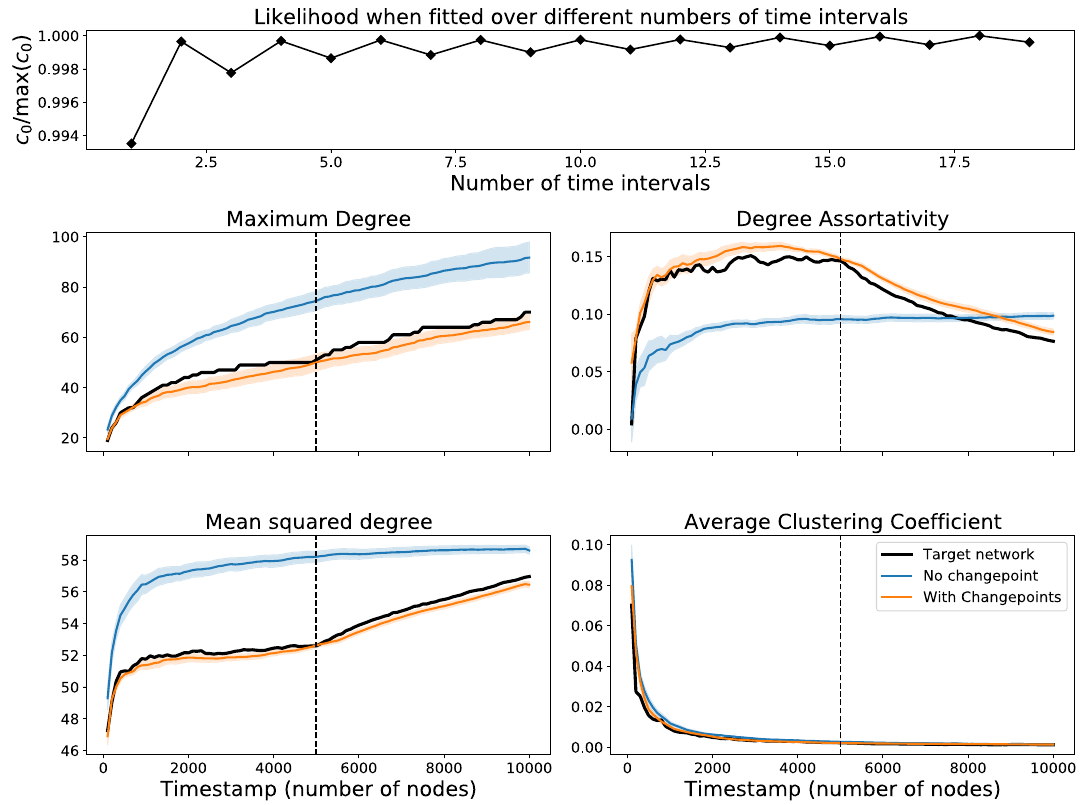
Figure 7. Investigation of a synthetic network (parameters described in text) with a single changepoint at timestamp t = 5000, signified by the dashed line in the lower plots. The upper plot shows how the normalised model likelihood varies as the estimated number of time intervals increases (the correct number is two). The lower plot shows how well an artificial model reproduces network statistics with no changepoints or with a single changepoint. The shaded area represents a 95% confidence interval over 10